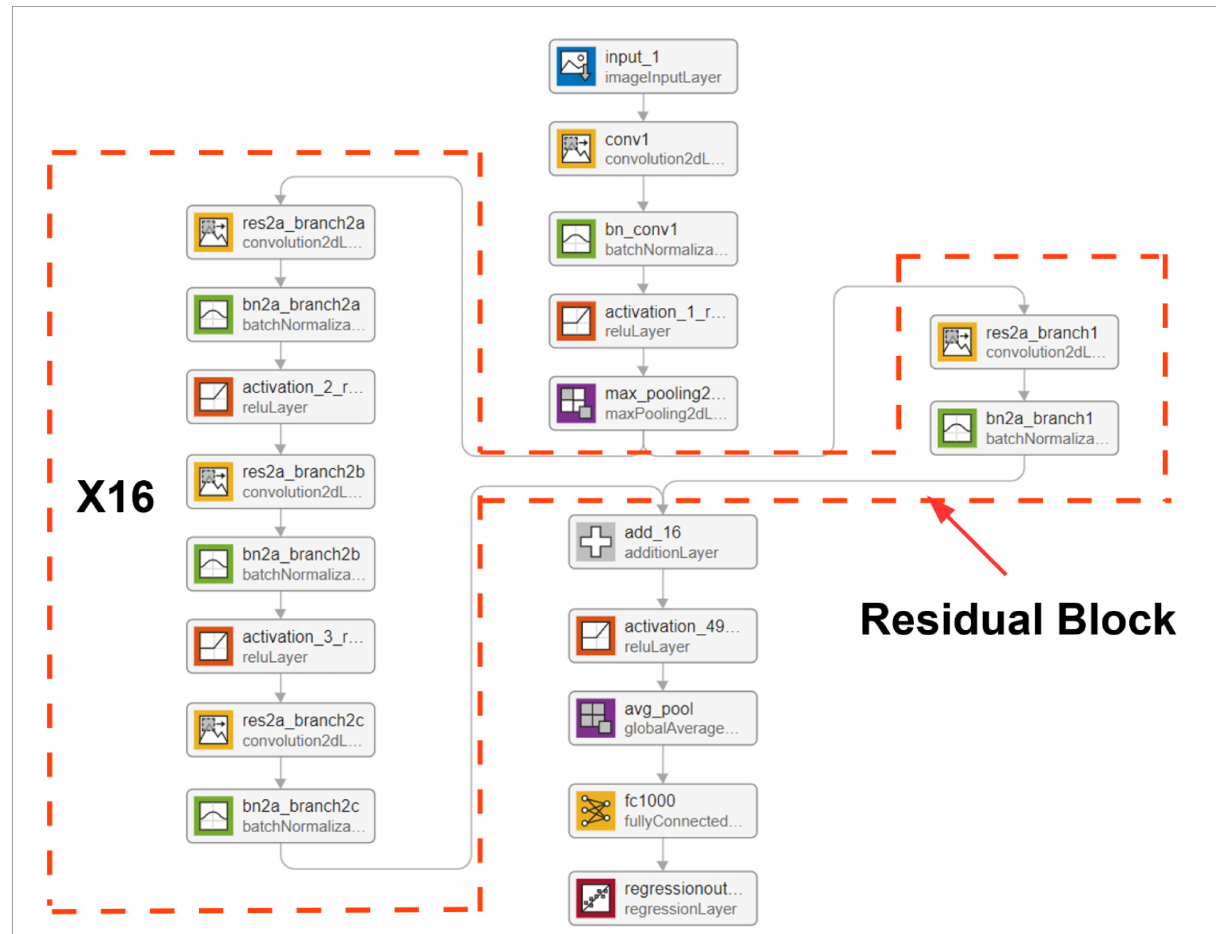
FIGURE4 Network architecture. The resNet50 design structure has 16 residual blocks, presenting 50 convolutional